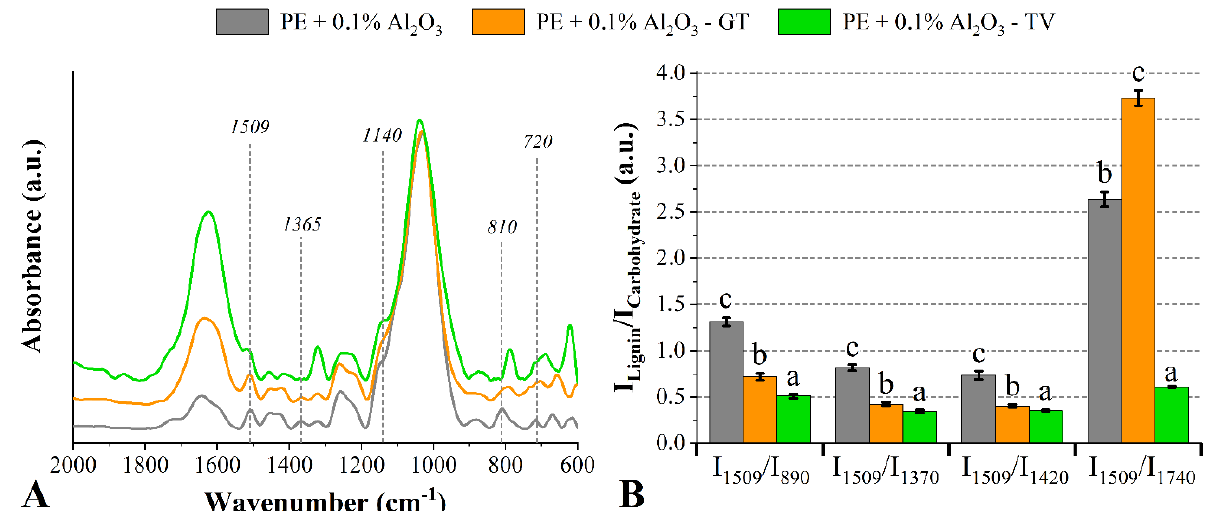
Figure 3. FT − IR spectra ( A ) and lignin/carbohydrate ratios ( B ) of the P. elliottii (P E ) woods treated with 0.1% of Al 2 O 3 exposed to the G. trabeum and T. versicolor fungi. Where: Different letters above the bars indicate statistically different means for each lignin/carbohydrate ratio.